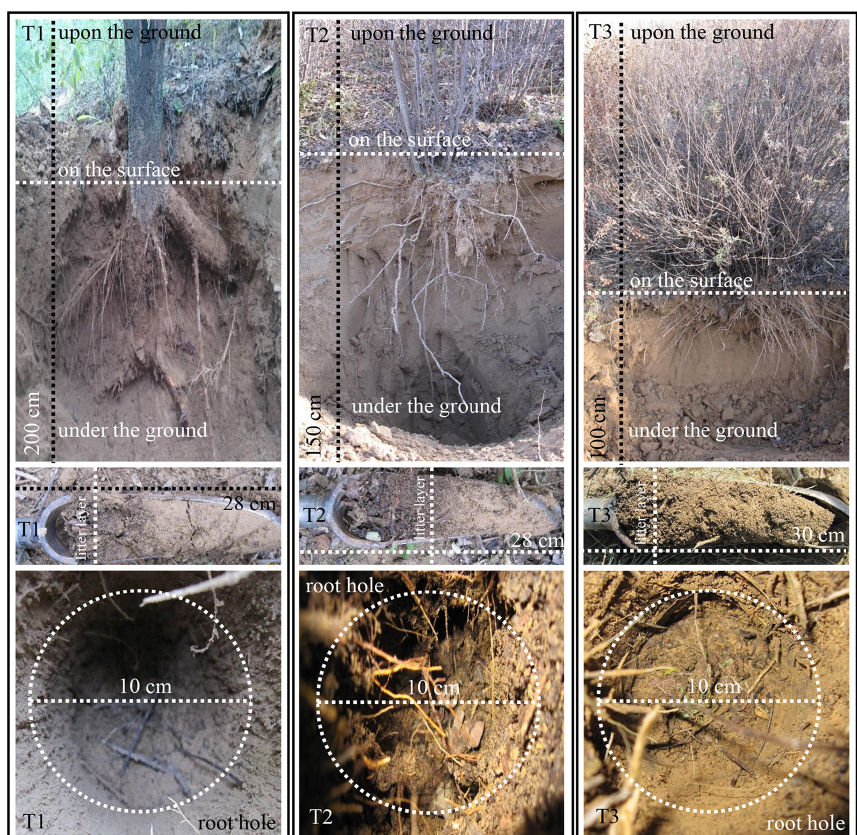
Figure 7. Morphological properties of three restoration vegetation types including the thickness of litter layer and the distribution of root system. The dashed lines indicate the diameter and depth of soil samples, approximately 10 and 30cm